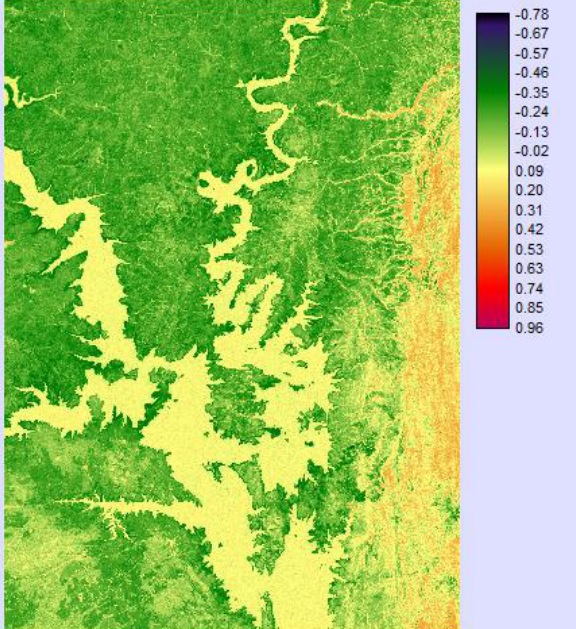
Fig.4: NBR of Post-fire Landsat ETM+ 2003